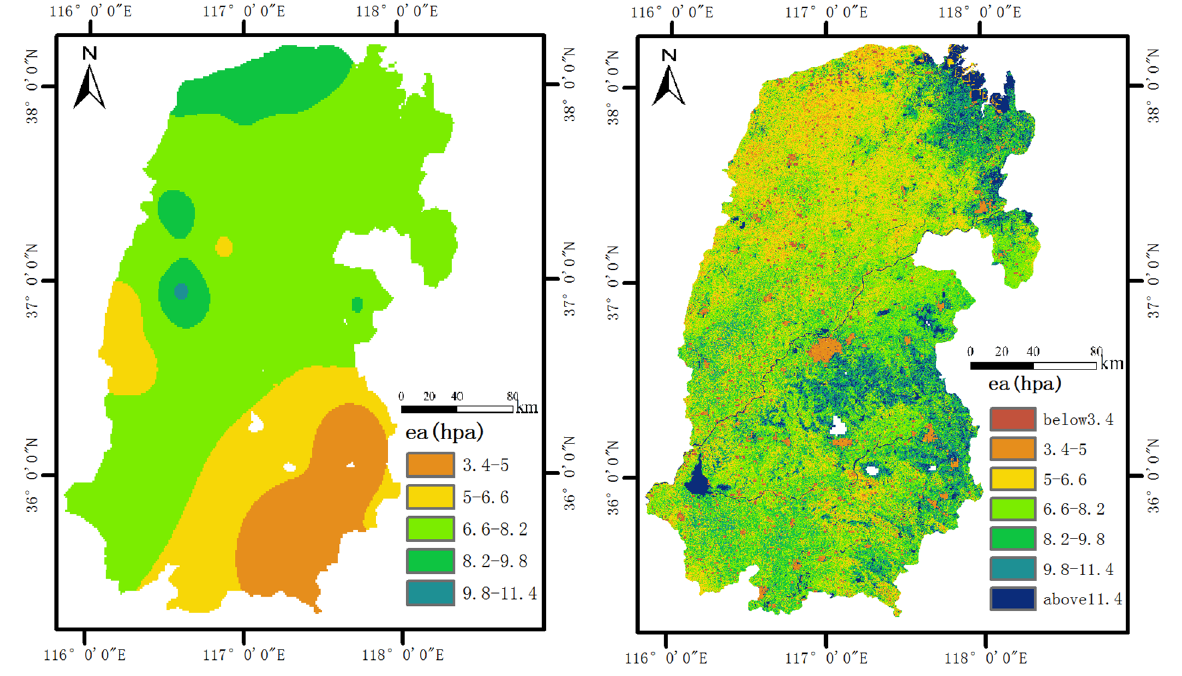
Figure 4. Spatial distributions of T a estimates from the IDW method ( left ) and the ADEBAT method ( right ) on 8 April, 30 August and 17 October in